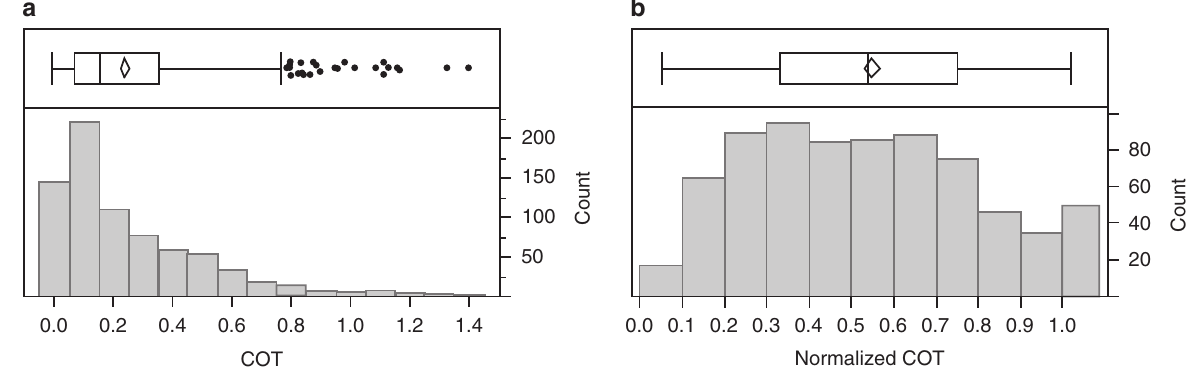
Figure 3 | Frequency distribution of cirrus optical thickness. Distribution of absolute COT ( a ) and nCOT ( b ) for cases where the maximum cloud layer depth is 2.5km. The data come from all four categories. The box-and-whisker plots show the 25 and 75% quartiles as the box, with the median value being the vertical line inside the box and outliers shown as dots. The diamond inside the box indicates the mean value (vertical vertices) and ± 95% confidence interval (horizontal vertices) for the data. The number of observations is shown on the right vertical axis. Note that the highest bin in b only contains values of